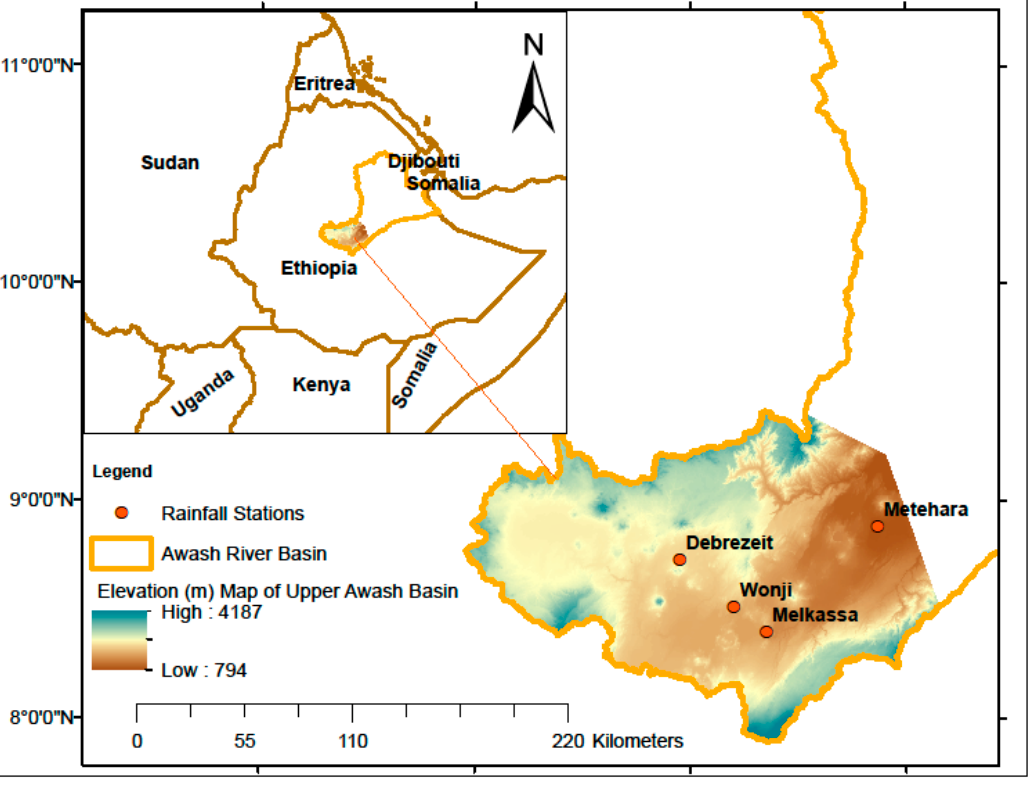
Figure 1. Location of the Upper Awash River Basin, Ethiopia .